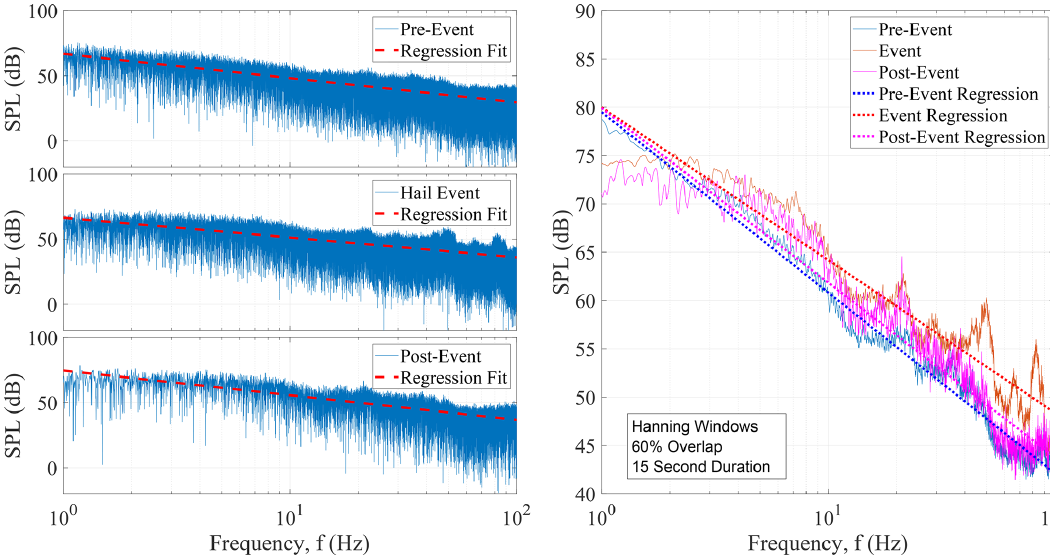
Figure 13. Frequency-domain infrasound measured with GLINDA during the Comanche County hail event at 23:15UTC on 22 May 2020.